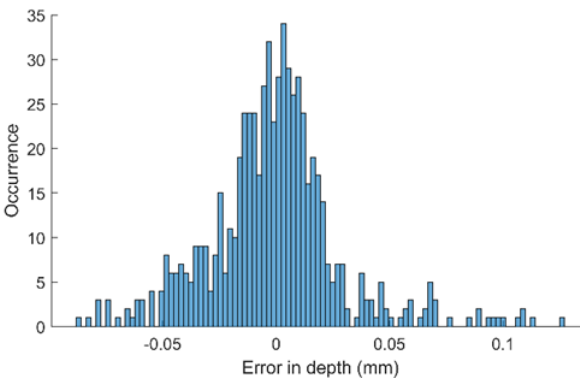
Figure 17. Histogram of differences between reconstructed surface and 533 measured probe